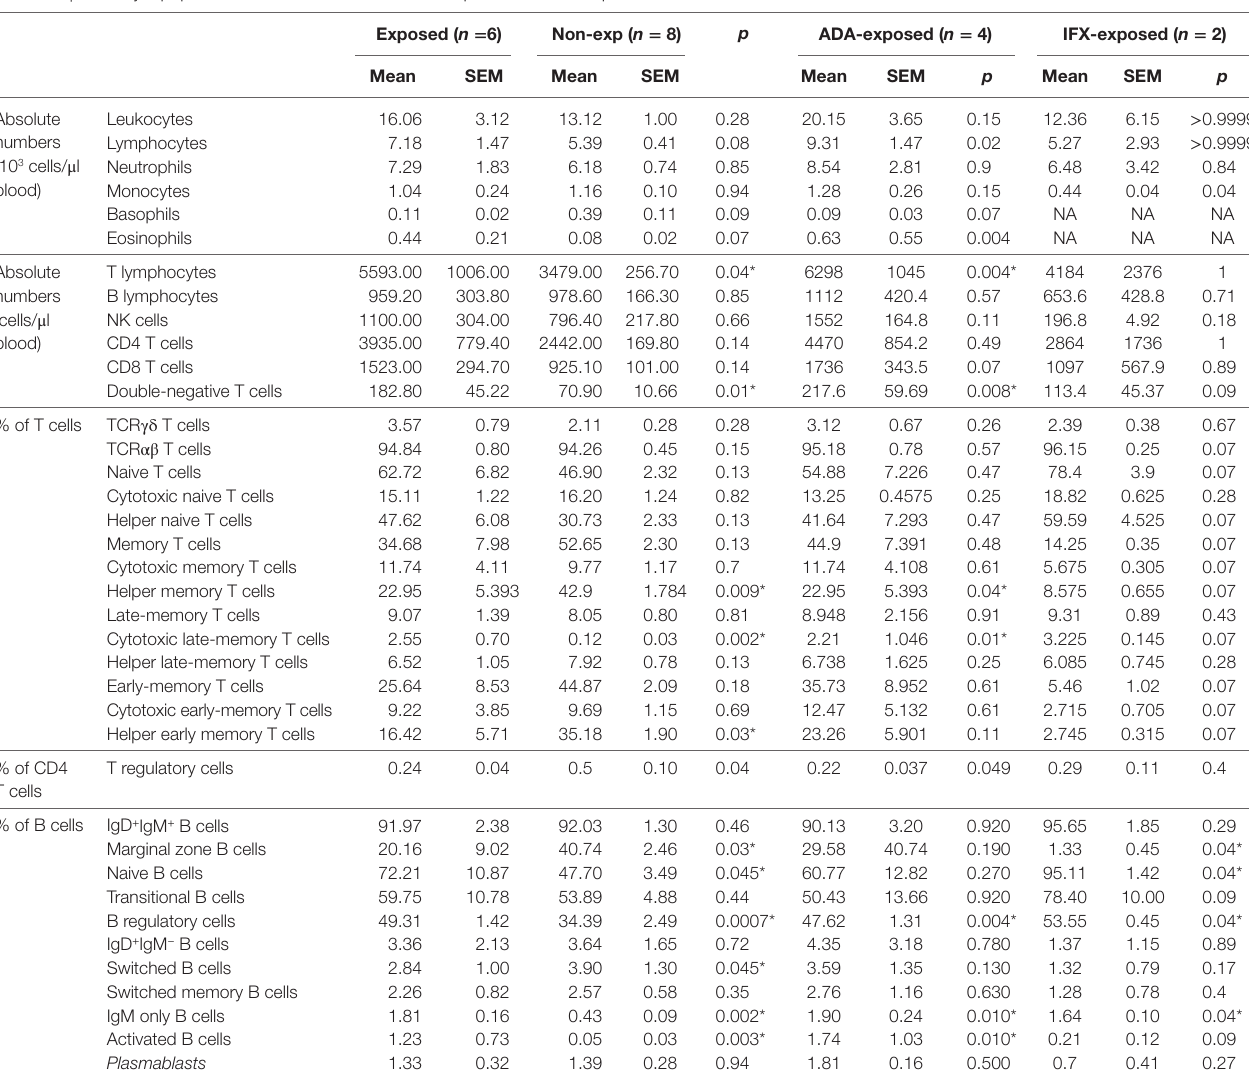
TaBle 2 | Leukocyte populations in umbilical cord blood of exposed and non-exposed infants. exposed ( n =